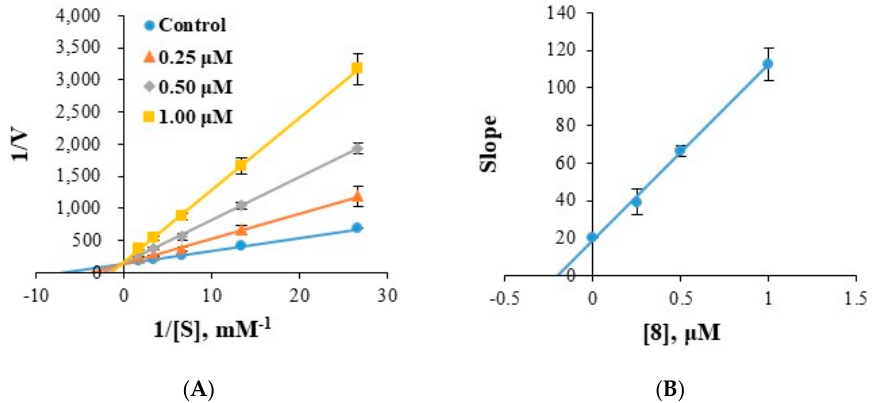
Figure 5. Lineweaver-Burk plots of hMAO-B inhibitions by 8 and their respective secondary plots ( A , B ) of slopes of Lineweaver–Burk plots versus inhibitor concentrations. Substrate concentrations ranged from 0.03 to 0.6 mM. Experiments were carried out at three inhibitor concentrations, that is, ~0.5, 1.0, and 2.0 times IC 50 values. Initial velocity was expressed as an increase in absorbance per min.